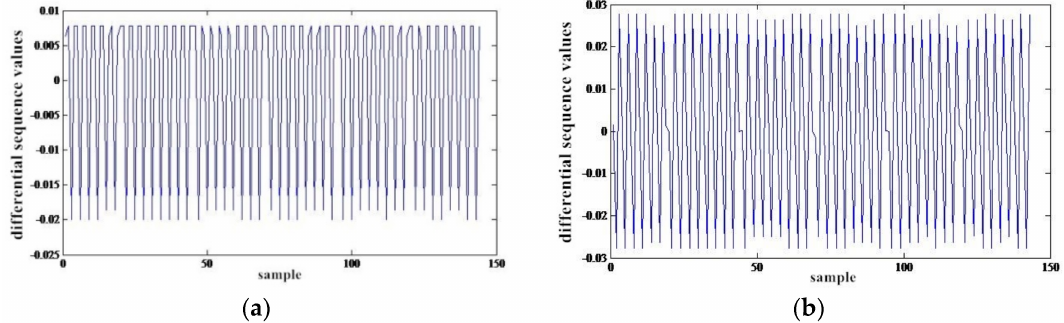
Figure 5. First- and second-order difference results of the original sequence. ( a ) First-order differential sequence; ( b ) Second-order differential sequence.